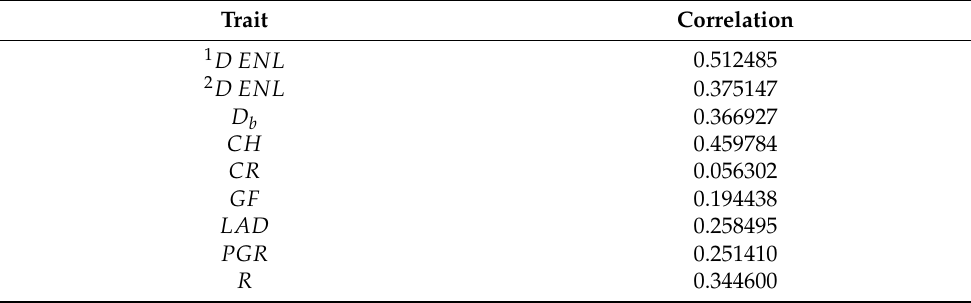
Figure A23. TLS correlation matrix at 1m grid size. Table A8. Overview of correlation between ULS and TLS traits at 1m grid